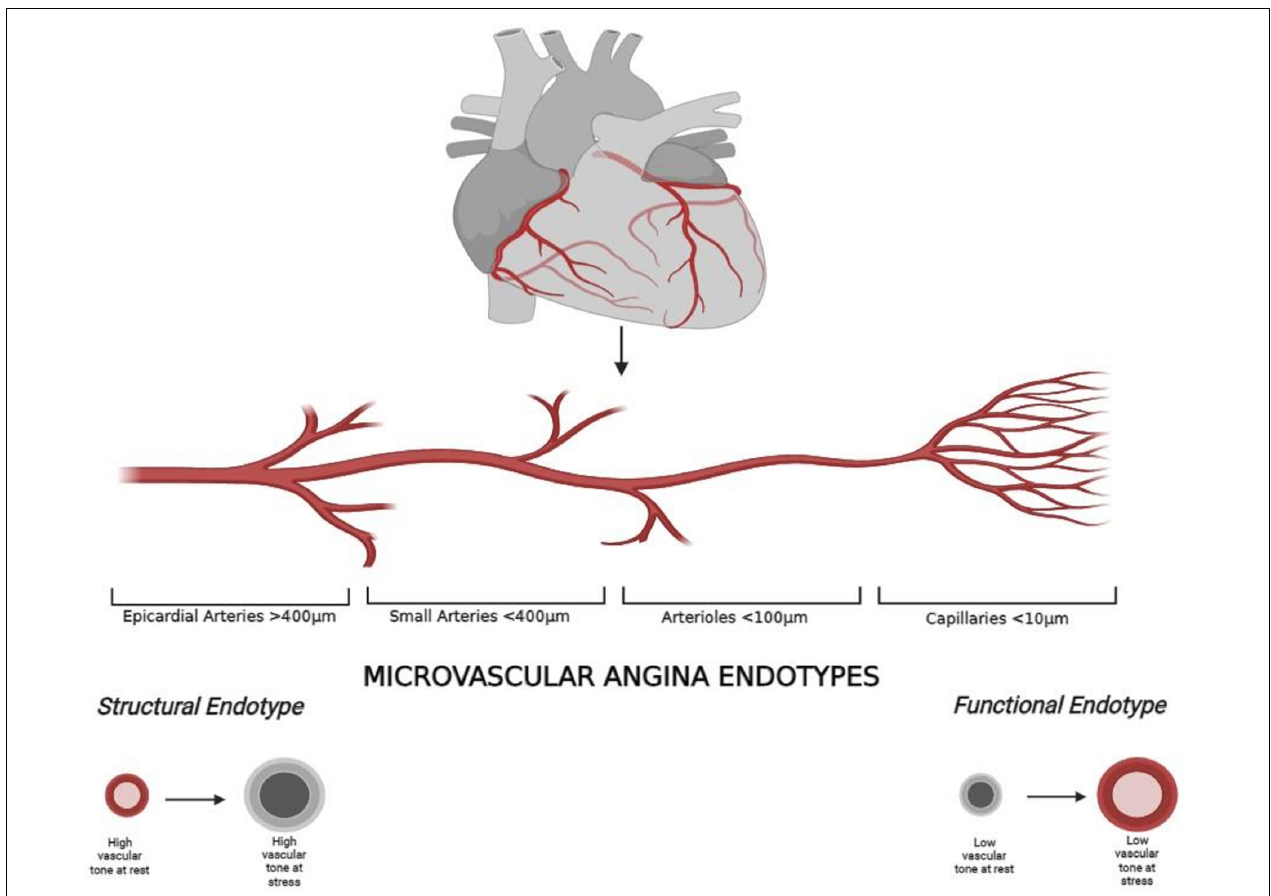
FIGURE 1 | Coronary macro- and microcirculation and microvascular angina